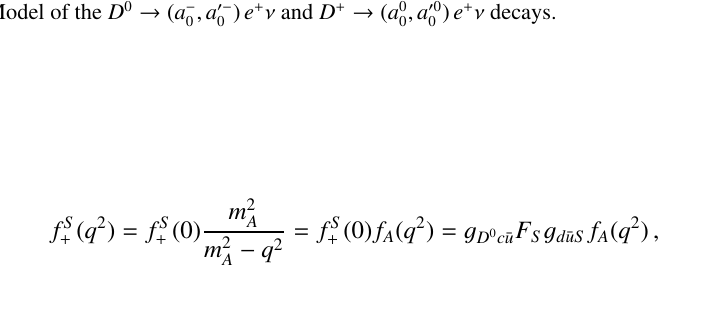
Figure 1. Model of the D 0 → ( a −